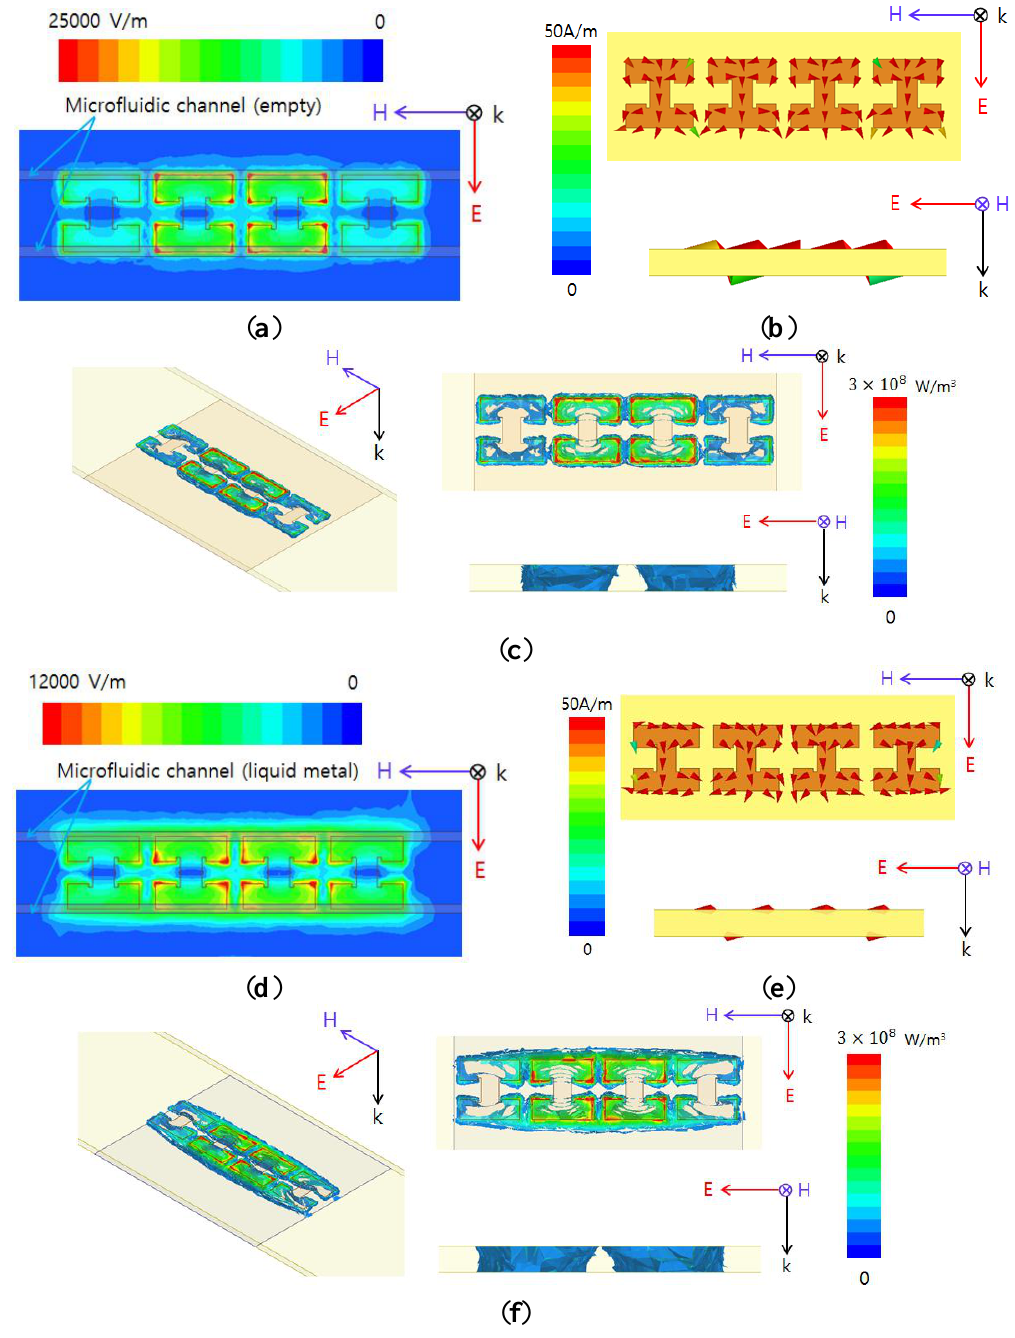
Figure 3. Simulated ( a ) Magnitude of electric field distribution; ( b ) Vector current density; ( c ) Volume loss density at 10.96 GHz when the microfluidic channels are empty Simulated; ( d ) Magnitude of electric field distribution; ( e ) Vector current density; ( f ) Volume loss density at 10.61 GHz when the microfluidic channels are filled with liquid